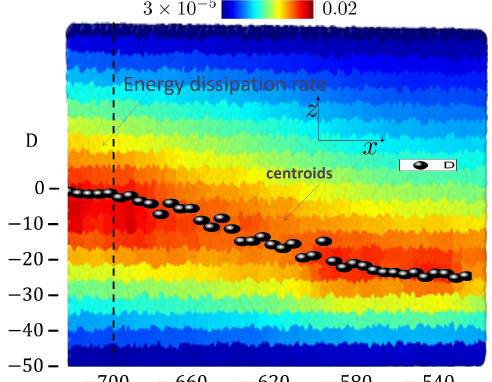
Figure 4. Color coded temperature field at a global strain of (cid:101) xz = 15%, corresponding to a time of t = 0.15/ ˙ (cid:101) xz = 1500 t LJ . The color bar shows the temperature range used in color coding. The ellipsoids (called in the image centroids) track the average position of the shear band. As expected, the highest temperatures occur inside the shear band. The dashed vertical line marks one of the cross sections for which temperature profiles are extracted from this data set and plotted in Figure 5, thus permitting a more quantitative